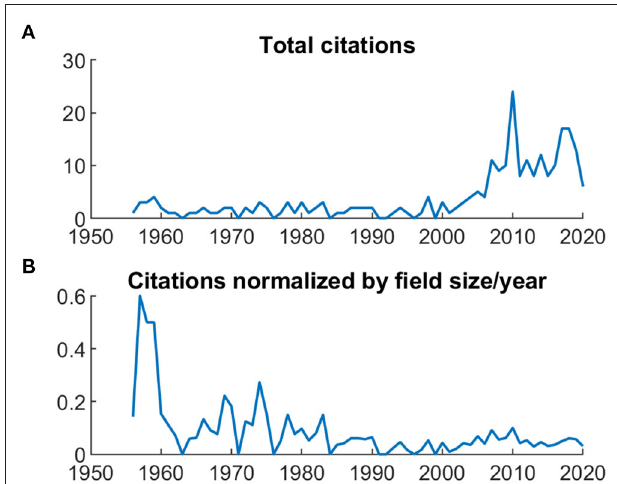
FIGURE 13 | Citation trajectories for an exemplary high-performing article (Beecher 1955). (A) Total citations. (B) Citations normalized by field size (i.e., number of articles published in the respective